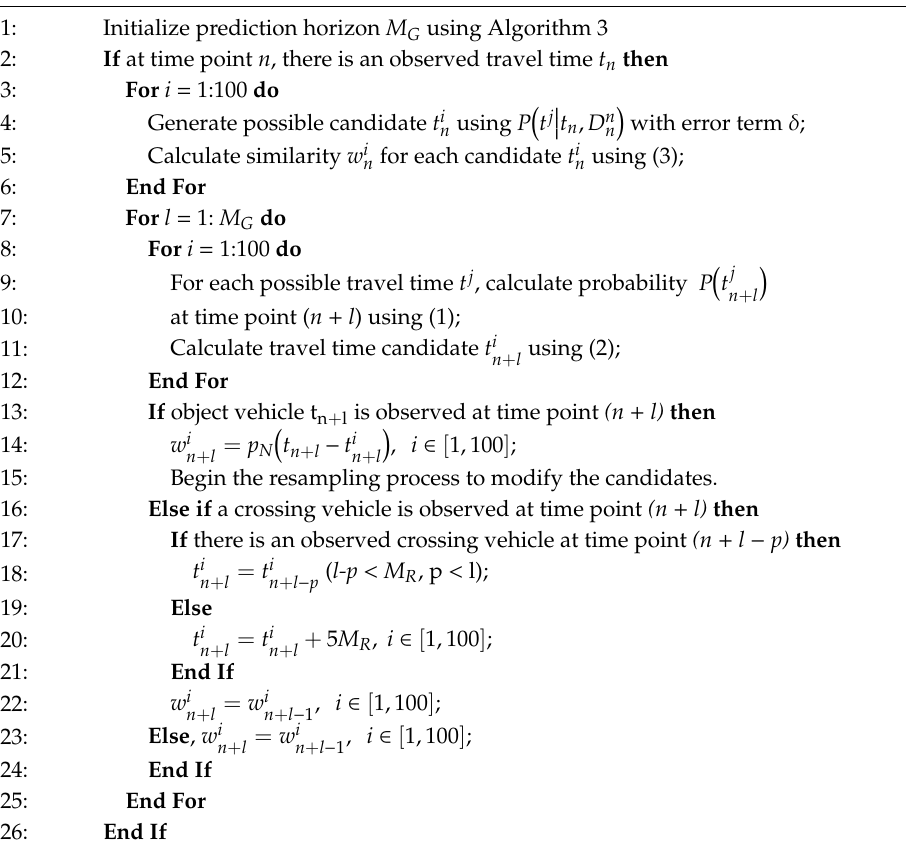
Algorithm 1. Proposed Travel Time Prediction